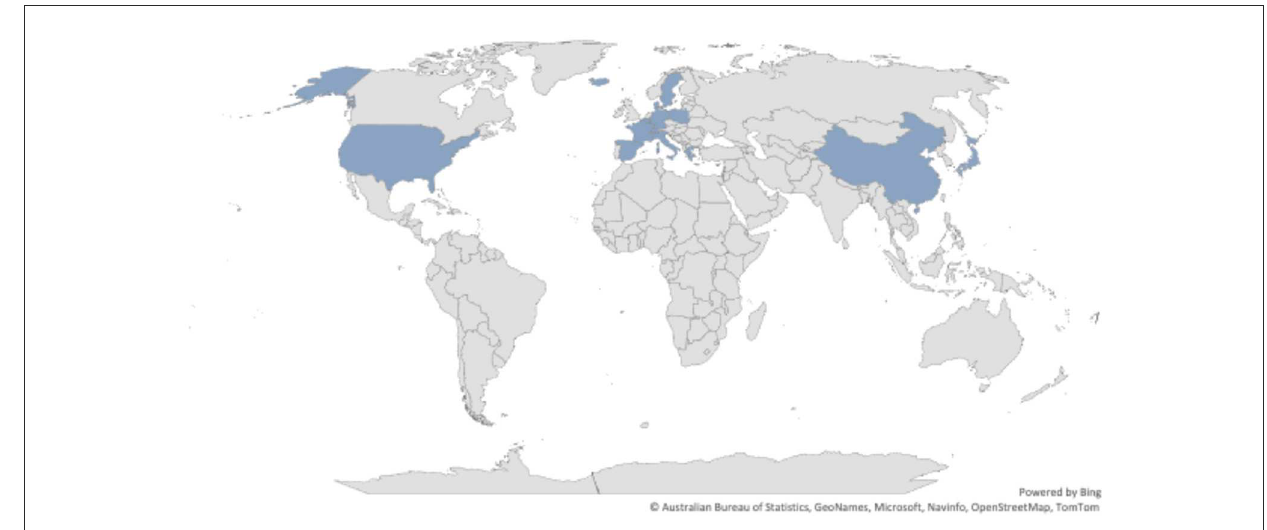
FIGURE2 Distribution of the countries for the 75 robots collected in the